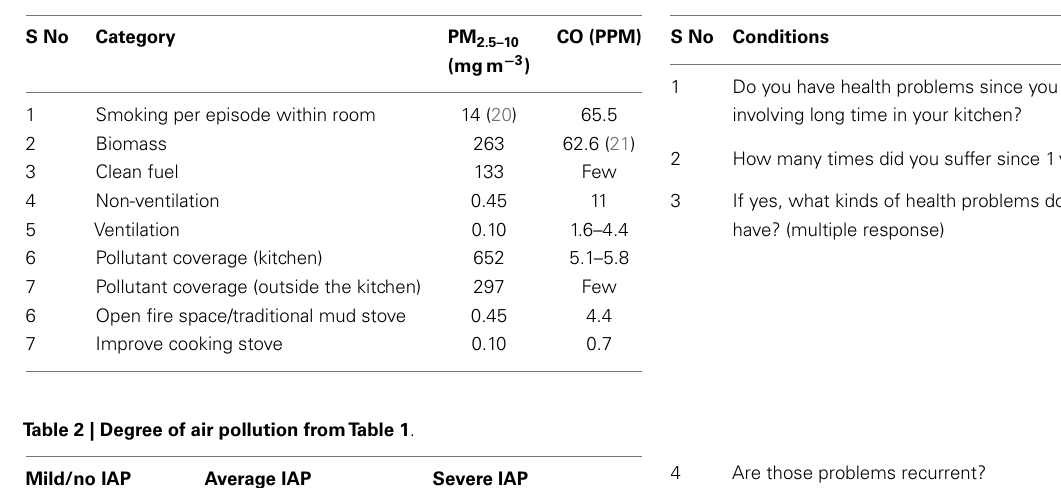
Table 1 |Average magnitude of pollutants within household .